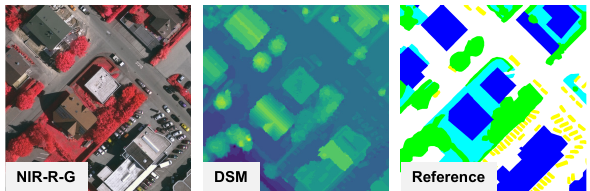
Figure 1. The challenge: given data in the form of a true or- thophoto (left) and the corresponding DSM (center), a labeling close to the reference labeling (right) should be achieved, where the classes are given by Impervious Surfaces (white), Building (blue), Low Vegetation (cyan), Tree (green) and Car